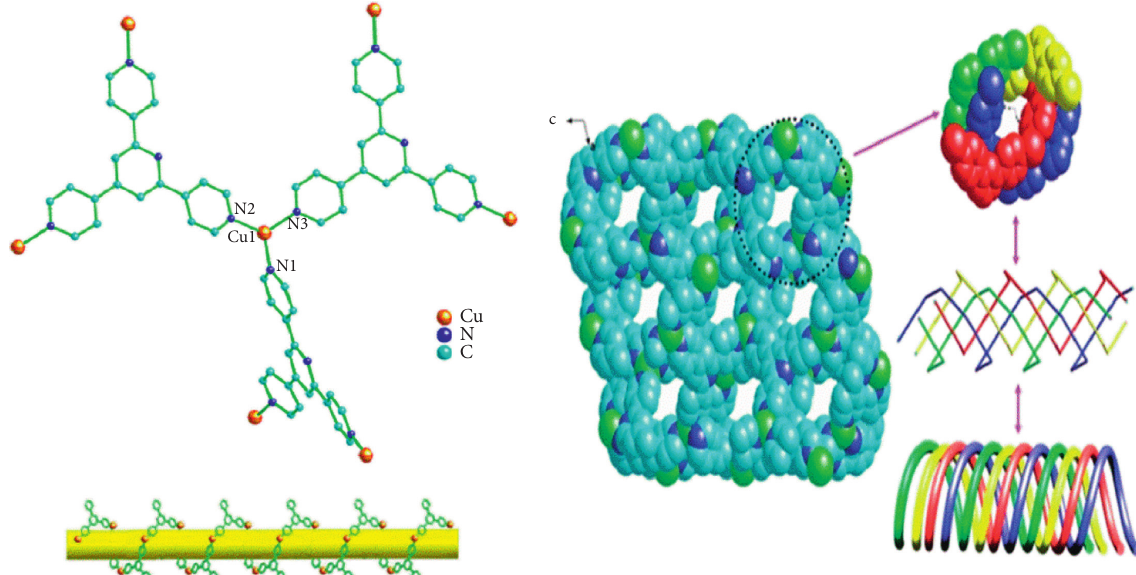
Figure 1: Diagram of Cu (I)-MOF and its 4-fold helical channel